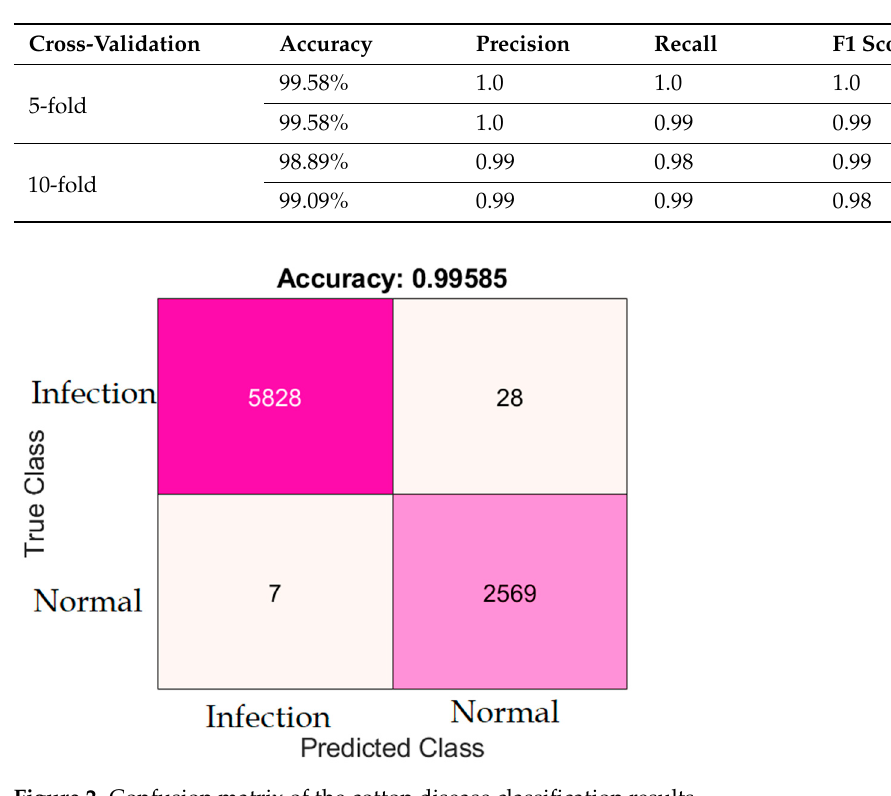
Figure 2. Confusion matrix of the cotton disease classification results. Table 2. Classification results of cotton disease.